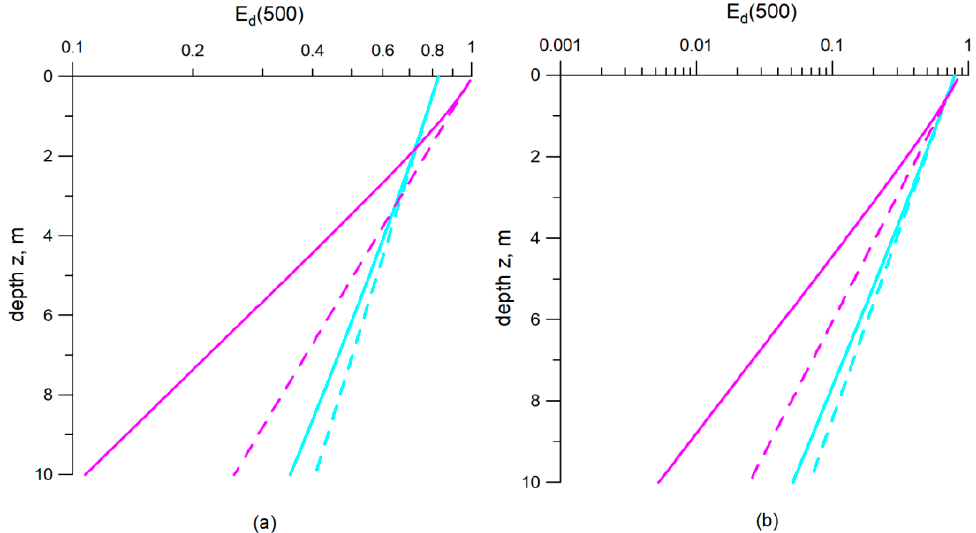
Figure 11. The downward irradiance E d (500) profiles for the case of the Black Sea and θ 0 = 25°, depending on the coccolithophore concentration ( N coc = 0, blue curves; N coc = 5 × 10 6 cell/L, magenta) and the absorption coefficient (on ( a ) with a (440) = 0.09 m − 1 , on ( b ), 0.53 m − 1 ). The solid line shows the results of numerical simulation, the dotted line shows calculation for K d = K 0 = const .